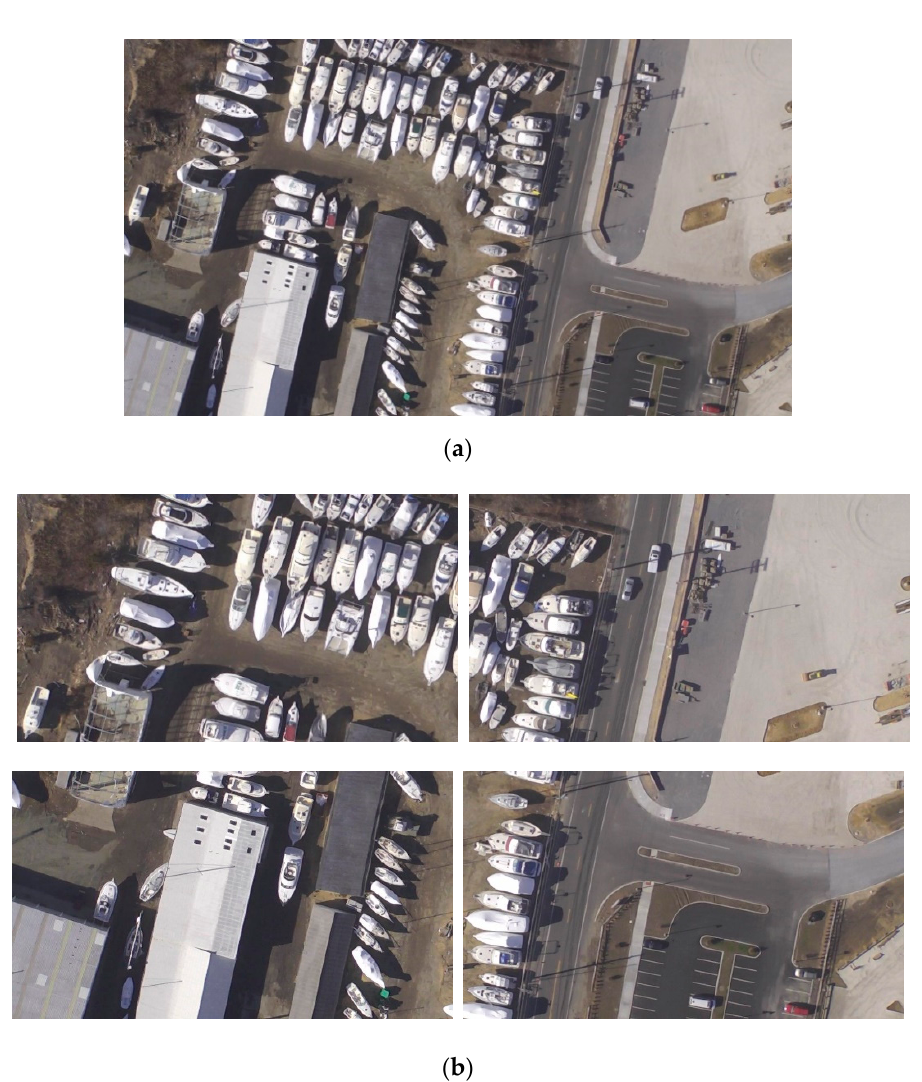
Figure 3. Examples of image pre-processing. ( a ) The raw data with resolution of 1920 × 1080 has many information; ( b ) The raw data is split into four parts.